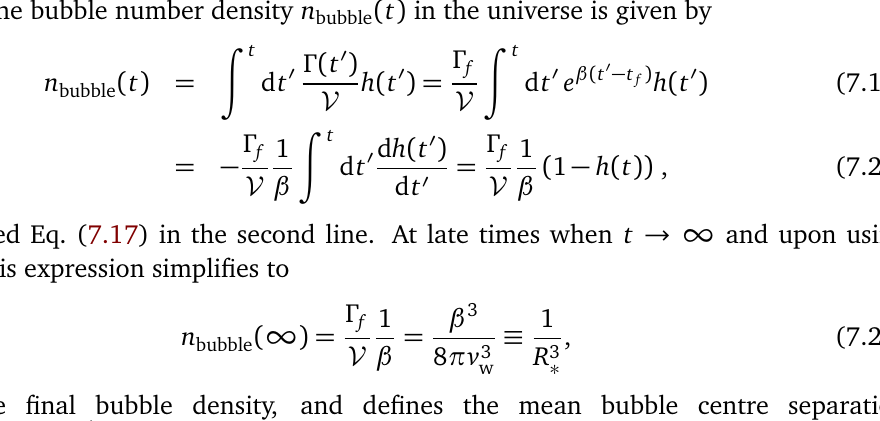
. The w = 0 by definition and w